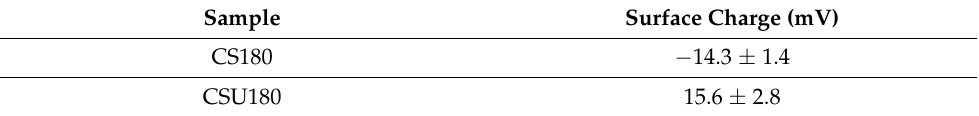
Table 3. Surface charge values for CNDs at neutral